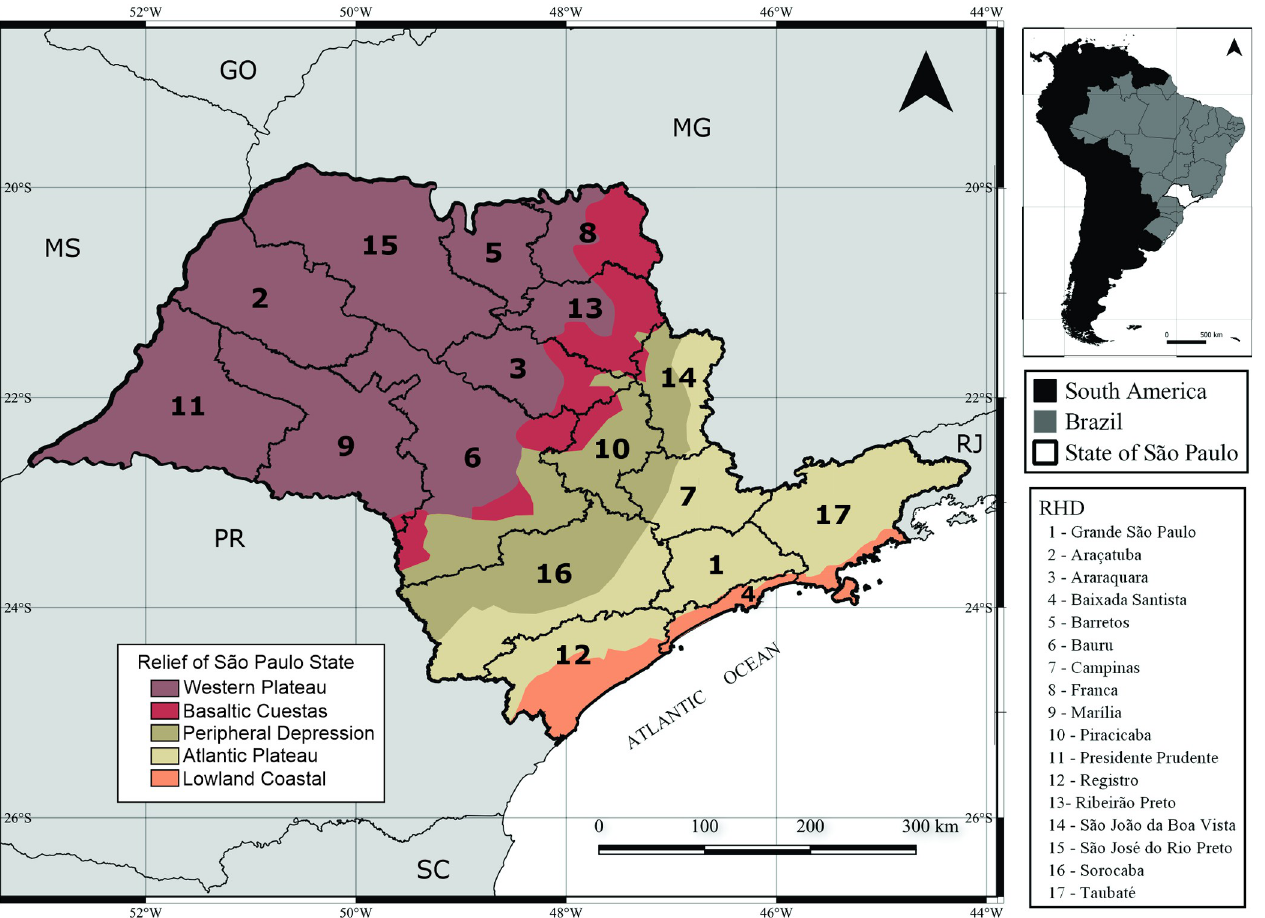
Fig 1. Location of the state of S ã o Paulo in Brazil and South America, its relief and the regional health departments (RHDs).